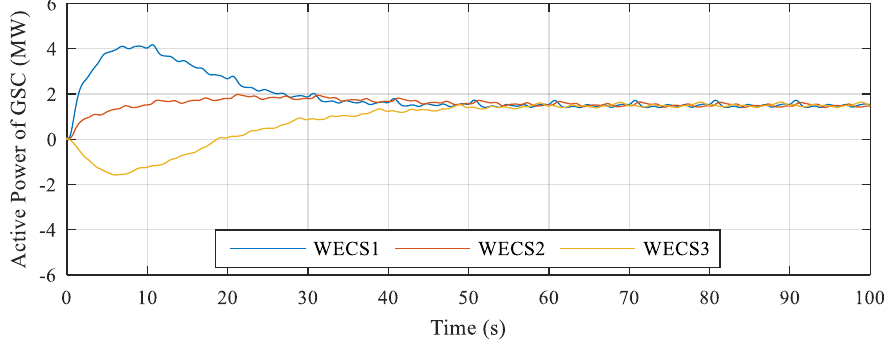
Figure 9. Active power of grid-side converter (GSC) without the proposed controller (Case 1).